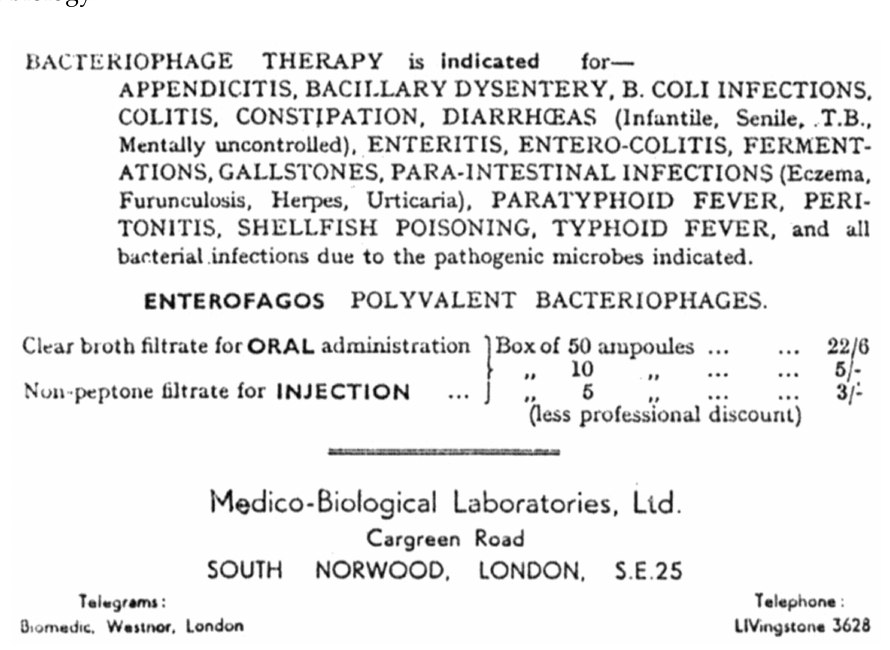
Figure 1. An advertisement for therapeutic bacteriophages from the 1920s (reprinted with the kind permission of Dr. J.